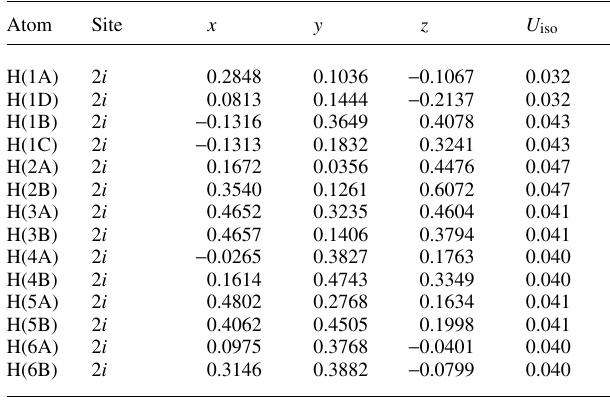
Table 2. Atomic coordinates and displacement parameters (in Å 2 )